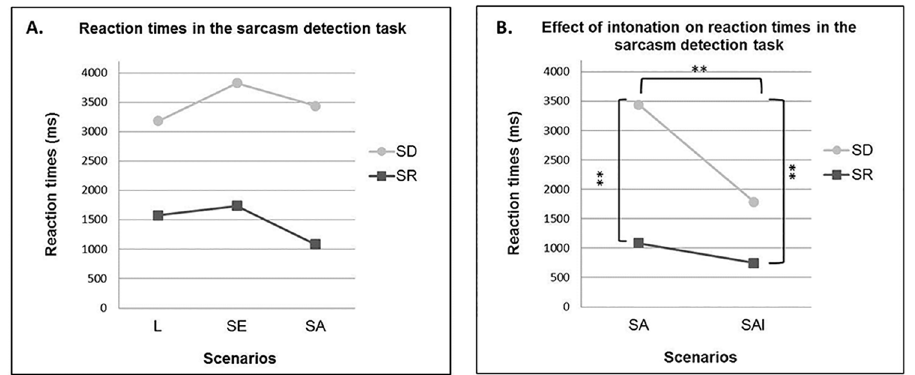
Fig 5. A. Reaction times (ms) in the Sarcasm Detection Task. Literal (L), Sarcastic Egocentric (SE), Sarcastic Allocentric (SA) scenarios. B. Reaction times (ms) in the Sarcasm Detection Task. Sarcastic Allocentric (SA) and Sarcastic Allocentric with Intonation (SAI) scenarios. The right bracket connects the SD group in the SA condition to the SR group in the SAI condition. The SD vs. SR groups in the SAI condition are connected by the left bracket. ** p <